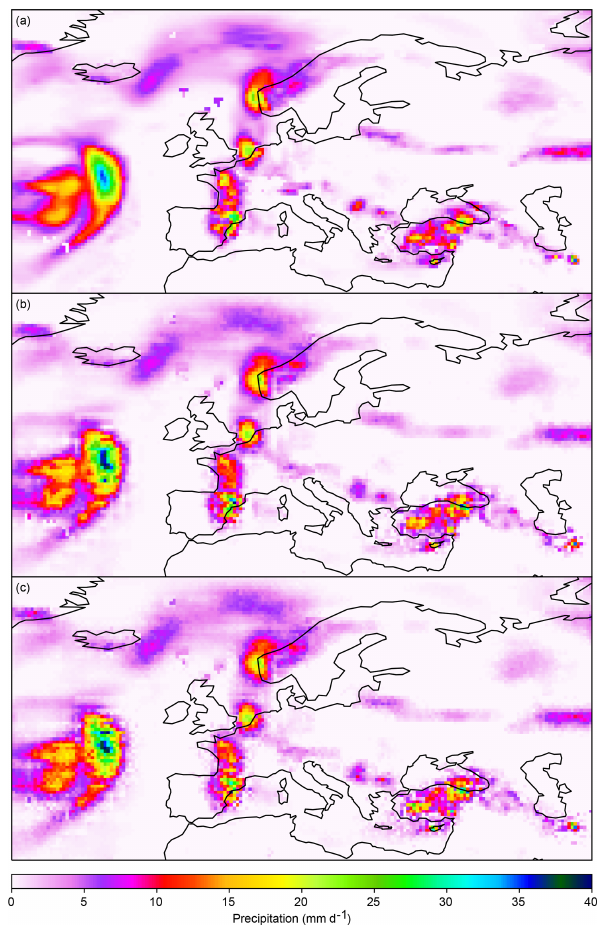
Figure 5. Statistical downscaling of precipitation from 2 to 0 . 5 ◦ spatial resolution in two small steps (2 to 1 ◦ and 1 to 0 . 5 ◦ ) versus in one big step. In this example, the MBCnSD algorithm is applied for statistical downscaling of spatially aggregated historical obser- vation data. Shown are precipitation fields over Europe for one par- ticular day: the original precipitation field in panel (a) and the result of statistical downscaling in two small steps and in one big step in panels (b) and (c) , respectively.